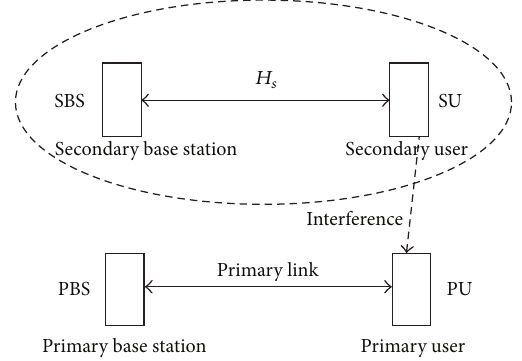
Figure 2: An underlay CRN with the primary system and the secondary